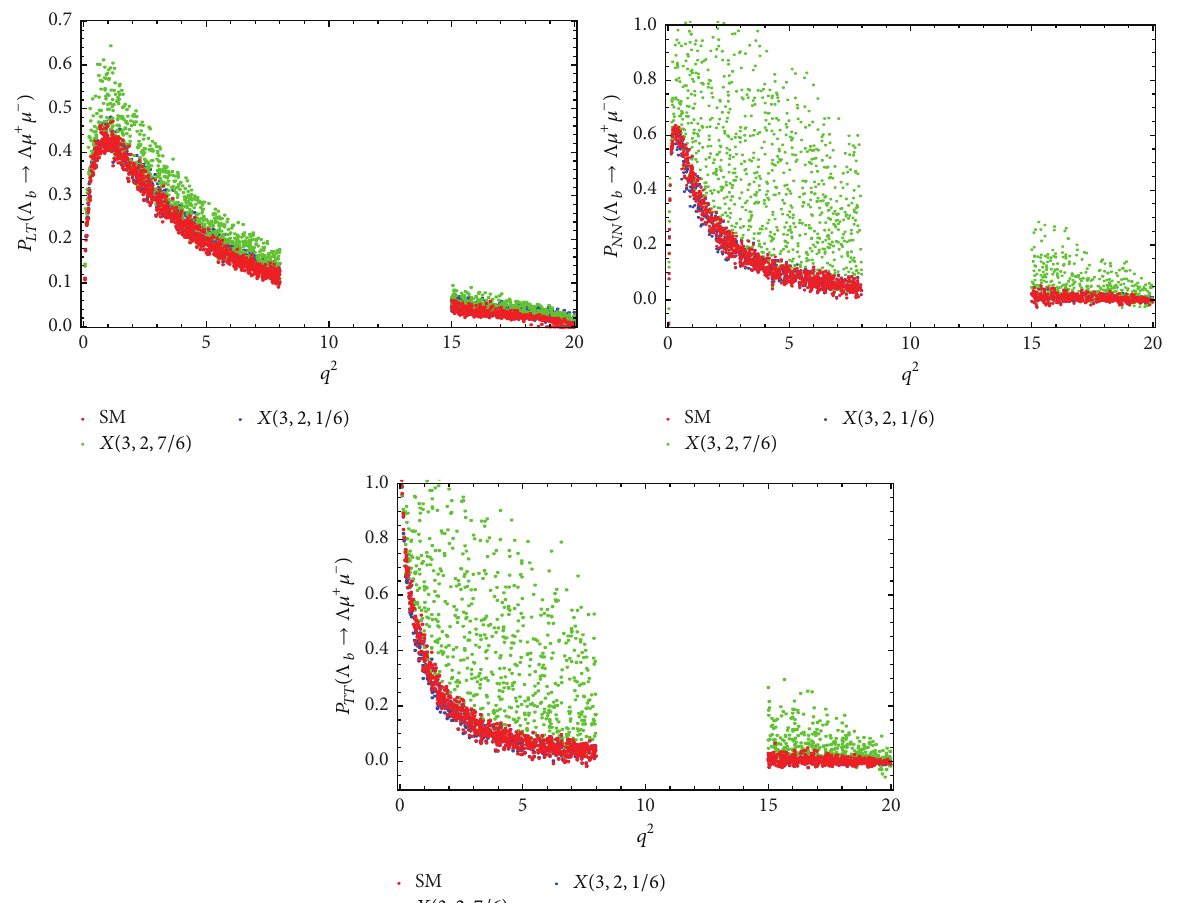
Figure 2: The dependence of double-lepton polarization asymmetries 𝑃 𝐿𝑇 , 𝑃 𝑁𝑁 , and 𝑃 𝑇𝑇 on 𝑞 2 , respectively.